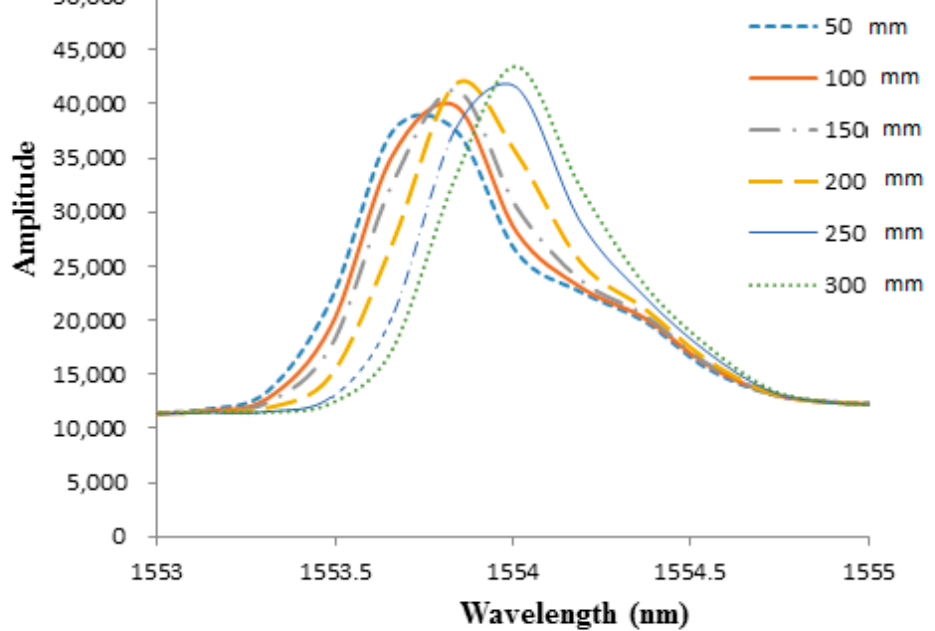
Figure 8. Optical spectra of Bragg wavelength reflected from the FBG sensor under various water levels with diaphragm thickness of 0.7 mm.